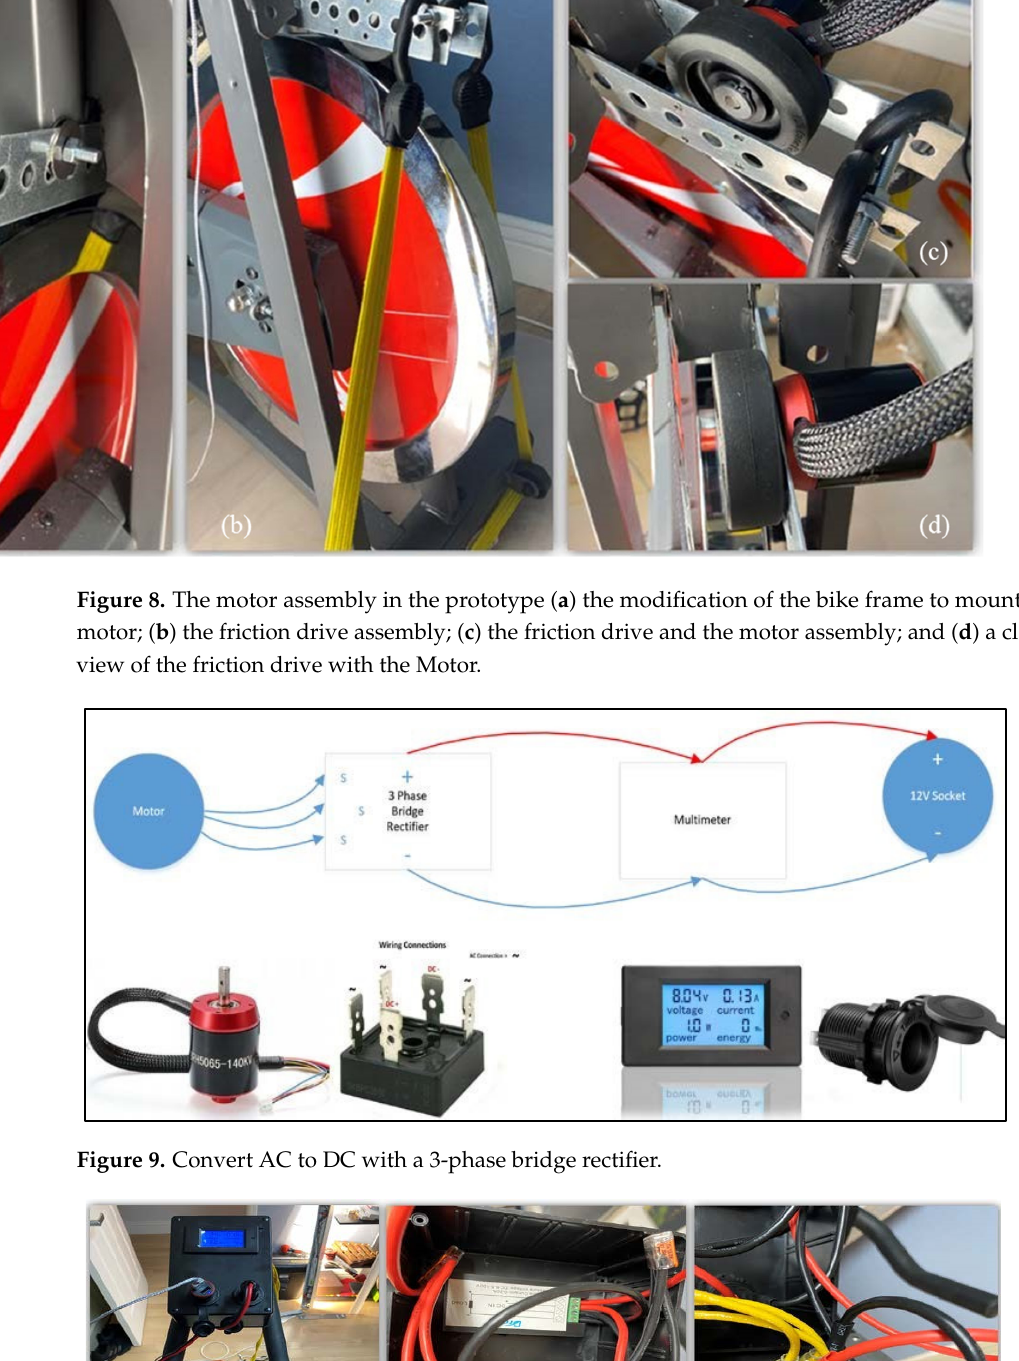
Figure 9. Convert AC to DC with a 3-phase bridge rectifier.